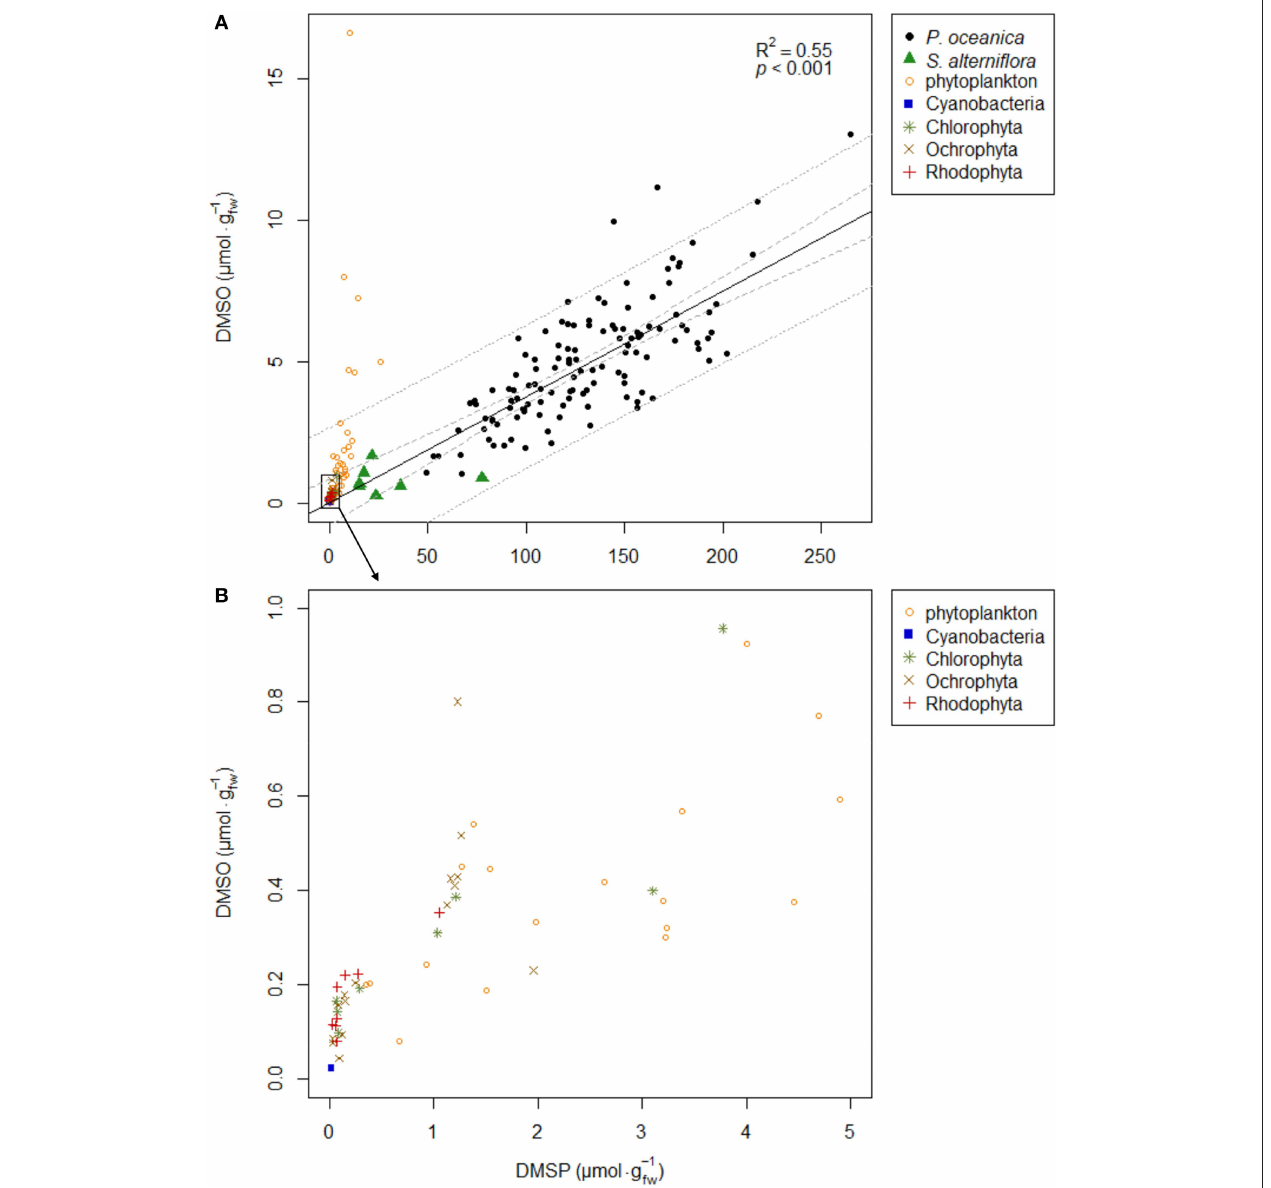
FIGURE 5 | Scatterplot of DMSP and DMSO concentrations ( µ mol.g − 1 fw ) in P. oceanica third leaf, S. alterniflora leaves, epilithic Cyanobacteria, macroalgae (Ochrophyta, Chlorophyta, and Rhodophyta), and marine phytoplankton communities. P. oceanica data are for individual leaf samples, all 10m depth survey and depth transect observations combined ( n = 129). S. alterniflora data are mean values from Husband and Kiene (2007), Husband et al. (2012), and McFarlin and Alber (2013). Epilithic Cyanobacteria and macroalgae data are mean species-specific pool sample values. Phytoplankton data are mean values from Simó and Vila-Costa (2006). Graph (B) is a zoom of graph (A) bottom left area framed by a rectangle. The legends of marine primary producer symbols are given next to the graphs. The solid black line on graph (A) is the linear regression modeling the relationship between P. oceanica DMSP and DMSO concentrations. Model R 2 and p -value are shown on the graph. 95% confidence (dashed gray lines) and prediction (dotted gray lines) intervals are plotted.